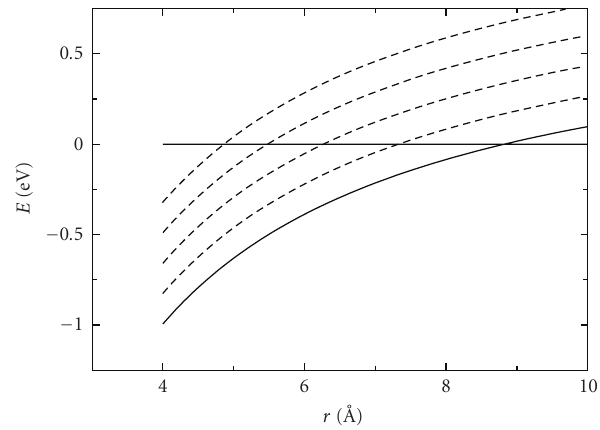
Figure 2: Potential energy curves of a D-A pair with E f ∞ = 0 . 9eV ( Δ G AN = − 1 . 6 eV) in a nonpolar solvent ( ε S = 1 . 88). The broken curves are the free energy curves of the final state with vibrational quanta ( v = 1500 cm − 1 ).